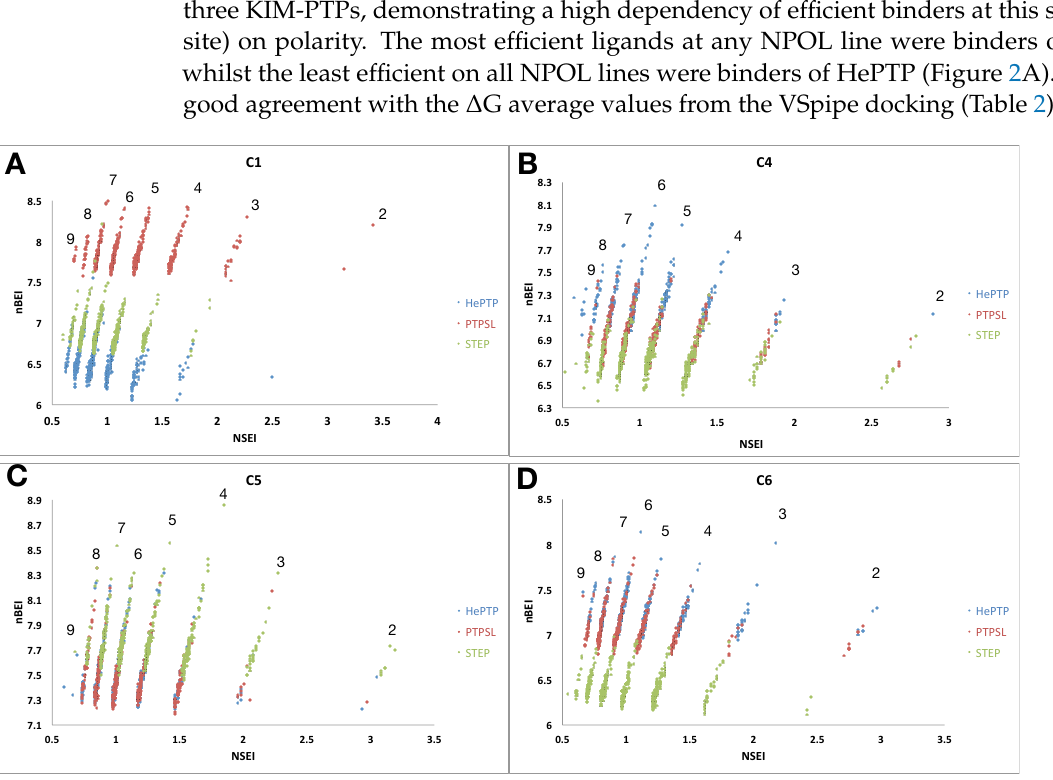
Figure 2. VSpipe NSEI/nBEI plot analysis of selected ligands (top 500 ranked by ∆ G) for clusters 1, 4, 5 and 6 for the KIM-PTPs (HePTP, PTPSL and STEP). Each panel is an NSEI/nBEI plot of the cluster ligands for the three KIM-PTPs: ( A ) cluster 1 binders, ( B ) cluster 4 binders, ( C ) cluster 5 binders, and ( D ) cluster 6 binders. The dots represent individual ligands and the colouring is as follows: HePTP (blue), PTP-SL (red), and STEP (green). Each diagonal line of compounds represents a specific NPOL (number of N and O atoms in the compound) as given by the number above each diagonal